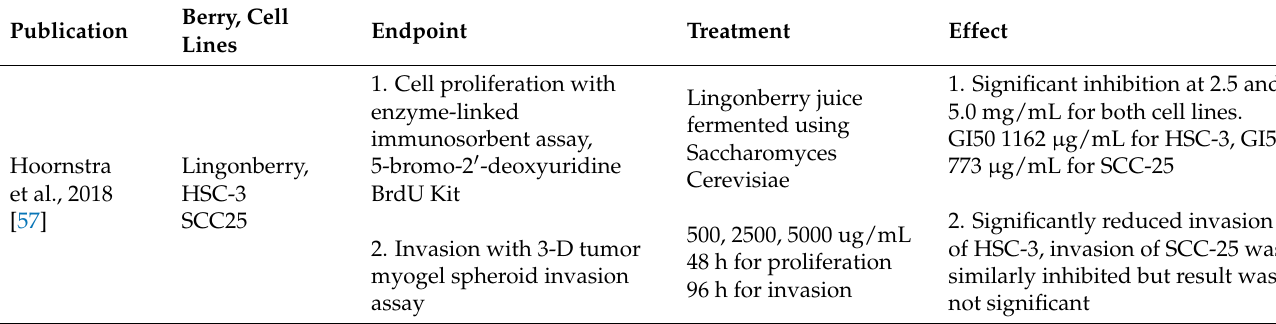
Table 3. Oral cancer. Main results of the cell